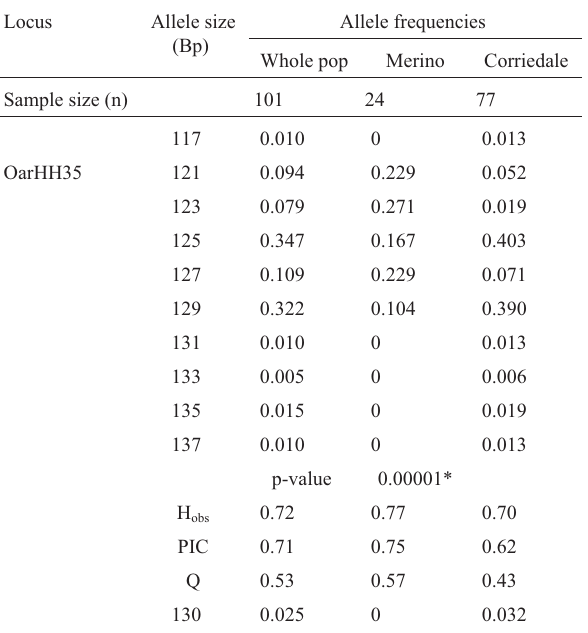
Table I - Loci, absolute allele sizes in base pairs, allele frequencies, ob- served heterozygosity (H 0bs ), polymorphism information content (PIC), exclusion probability (Q) and number of individuals analyzed per locus and sample. The whole population combines all the Merinos and Corrie- dales; p-values refer to the comparison of allele frequency distributions between Merino and Corriedale samples: *and NS means significant and non-significant difference, respectively. Markers are followed by ♦ if their absolute allele sizes are not concordant with those reported in the lit- erature.